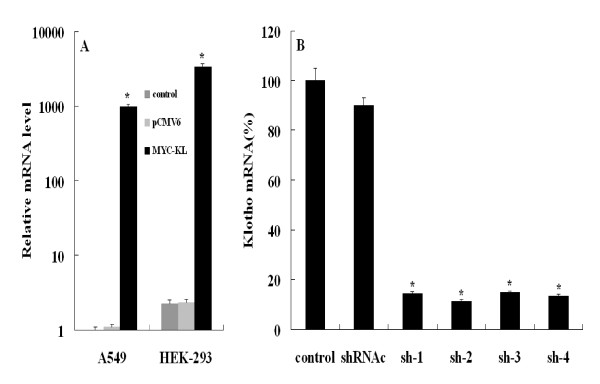
Relative klotho gene transcripts by qRT-PCR. (A) A549 and HEK-293 cells transfected with either MYC-tagged klotho expressison vector (MYC-KL) or an entry vector (pCMV6). (B) A549 cells transfected with four klotho directed-shRNAs and a negative control-shRNA (shRNAc). Data shown are the mean results ± SD of a representative experiment performed in triplicate (n = 3), *indicates p < 0.01. Statistical comparisons showed that our klotho expression plasmid and klotho-specific shRNA could work efficiently.